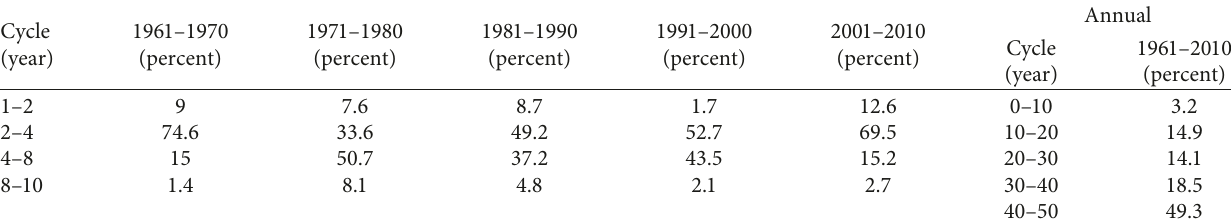
Table 5: The area covered by Iran’s thunderstorms during different